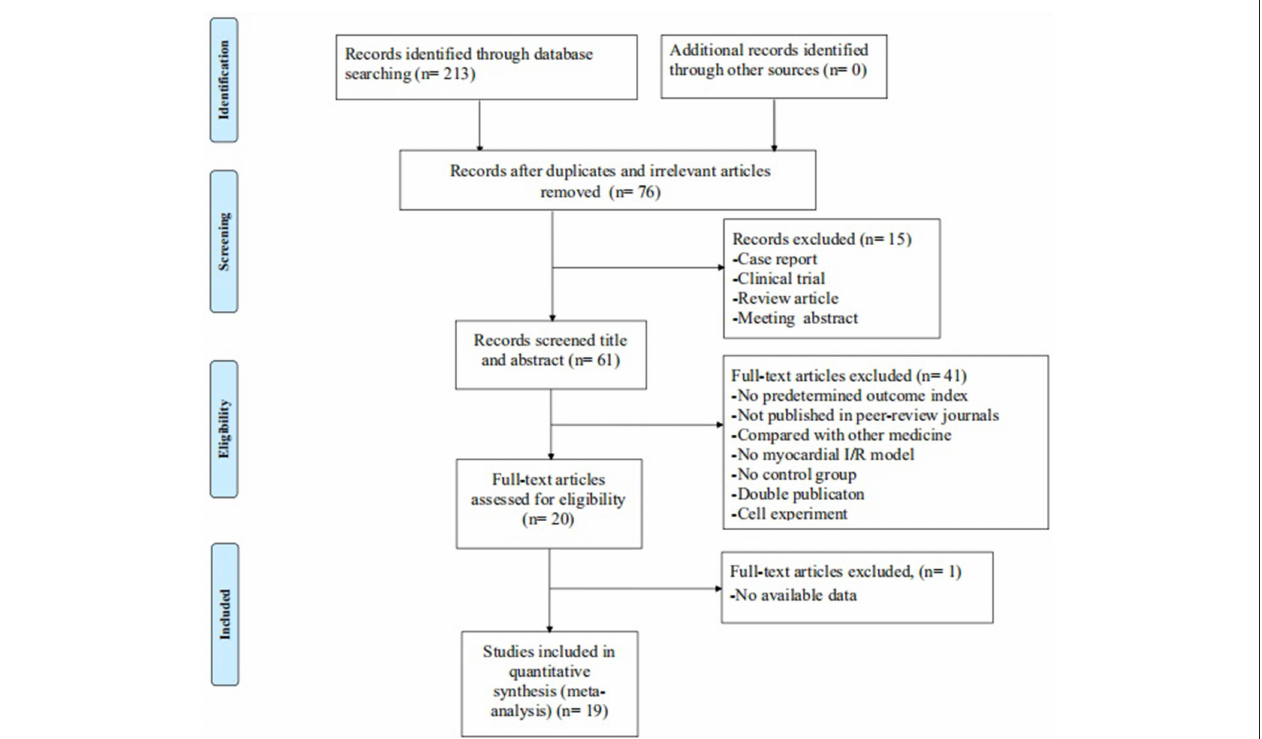
FIGURE 2 | Flow diagram of the systematic